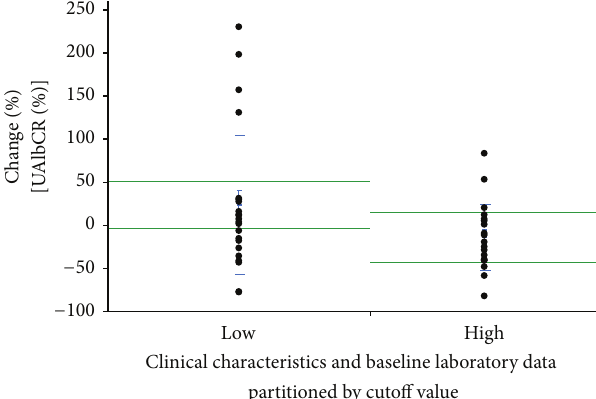
Figure 4: % change in urinary concentrations of Alb normalized by urinary concentrations of creatinine (UAlbCR) defined by the cutoff value of urinary concentrations of angiotensinogen normalized by urinary concentrations of creatinine (UAGTCR) before treatment. When all patients were redivided into two groups, those with higher UAGTCR levels before treatment (Group H, 𝑛 = 20 ) and those with lower levels (Group L), % change in UAlbCR was significantly lower in Group H than in Group L ( −14.6 ± 8.6 % versus +22.8 ± 16.8 %, 𝑃 = 0.0327 ).